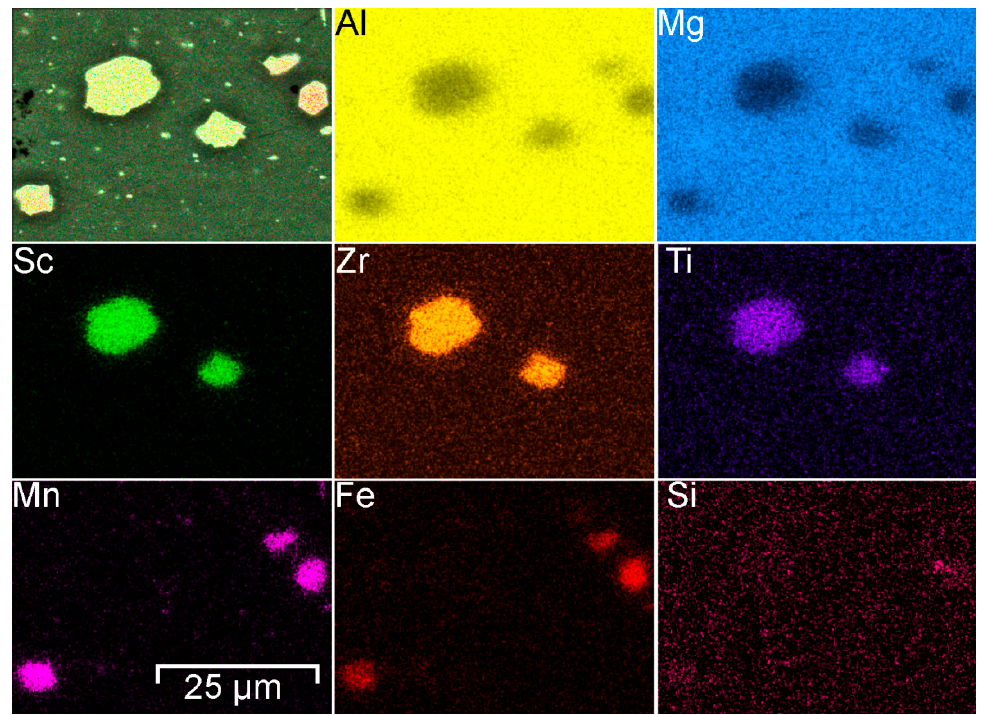
Figure 4. Element distribution in the HAZ. Presence of Al-Sc-Zr-Ti and Mn-Fe-Al phases was detected.